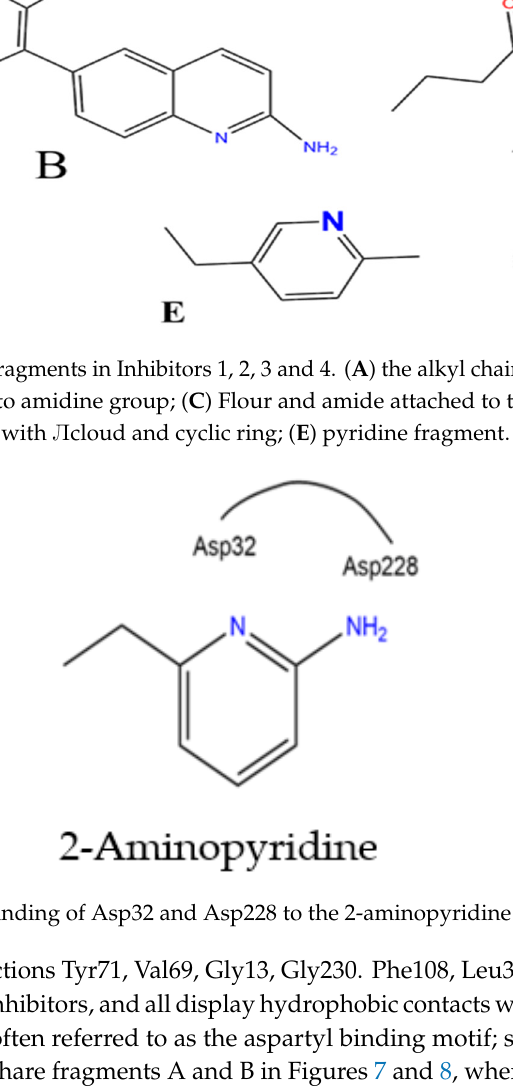
Table 4. Correlation coefficients (R 2 ) of Δ H with contributing energies (from Table 2) for groups of inhibitors.